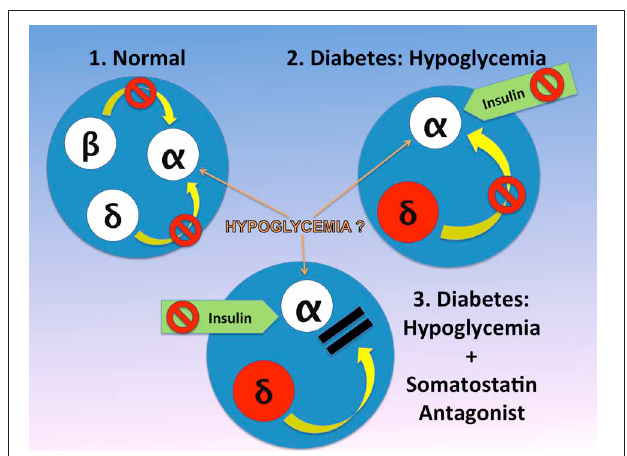
FIGURE 2 | In the normal physiology, the α -cell is under the tonic inhibitory influence of insulin and therefore somatostatin inhibition of α -cell may be of minor or no importance (Singh et al., 2007). This is in contrast to diabetic islets in diabetes, where α -cell may be more sensitive to insulin and in addition, both circulating and pancreatic somatostatin, are increased. It is generally believed that hypoglycemia is a strong stimulator of glucagon release from the α -cell. However, in islets in-vitro the effect of hypoglycemia is not consistent. This difference may reflect the fact that between in-vitro and in-vivo systems, in-vivo the islets have abundant blood flow, which brings to the islet other factors such as amino acids (i.e., arginine) that can stimulate glucagon release. We hypothesize therefore, that hypoglycemia has an effect only when amino acids or other substances found in blood, are present. In absence of the tonic effect of insulin, somatostatin is the only endogenousinhibitor of glucagon release and insulin exerts a strong inhibitory effect on the α -cell. Therefore, when an antagonist blocks the α -cell receptors, despite the inhibitory effect of injected insulin, the α -cell can release normal amounts of glucagon (Vranic, 2010). The figure is modified from that we previously reported